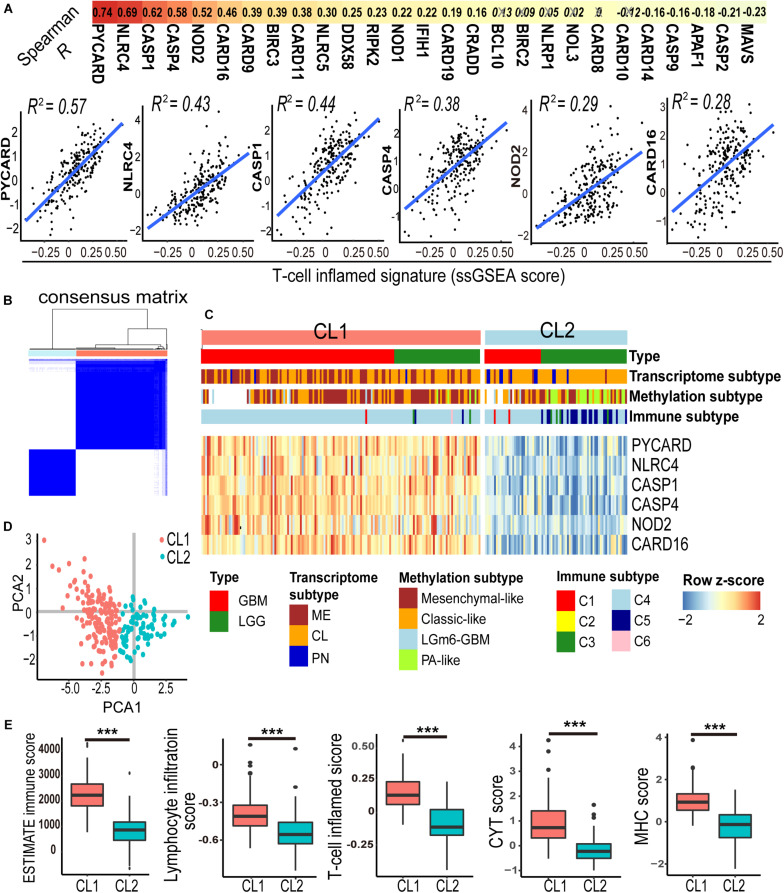
A panel of six-CARD genes associates with T lymphocyte infiltration in TCGA IDH wild-type gliomas. (A) Correlation between CARD gene expression and T-cell inflamed ssGSEA score. Top depicts Spearman R values. Non-significant correlations are crossed out. Scatter plots show fitted coefficient R2 values. (B,C) Consensus clustering matrix and heatmap with the six-CARD genes identified two clusters (CL1 and CL2). Histological and molecular subtypes were annotated for each patient. (D) PCA of two clusters. (E) Comparisons of immune score (from ESTIMATE), lymphocyte infiltration and T cell inflamed scores (from ssGSEA), and CYT and MHC scores (from mean gene expressions) between two clusters. P values: ***, <0.001.